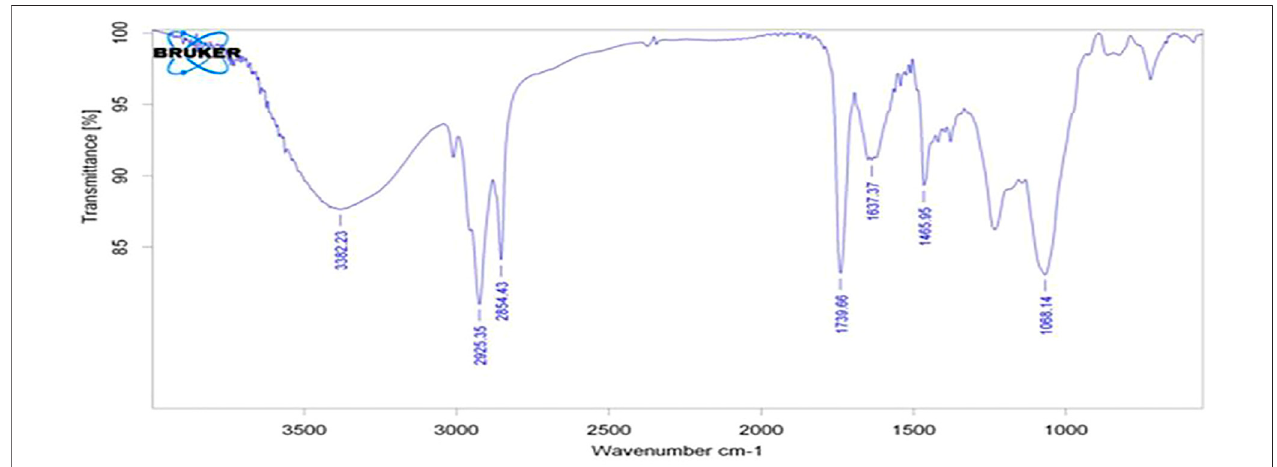
FIGURE 2 | Bioactive evaluation of silver